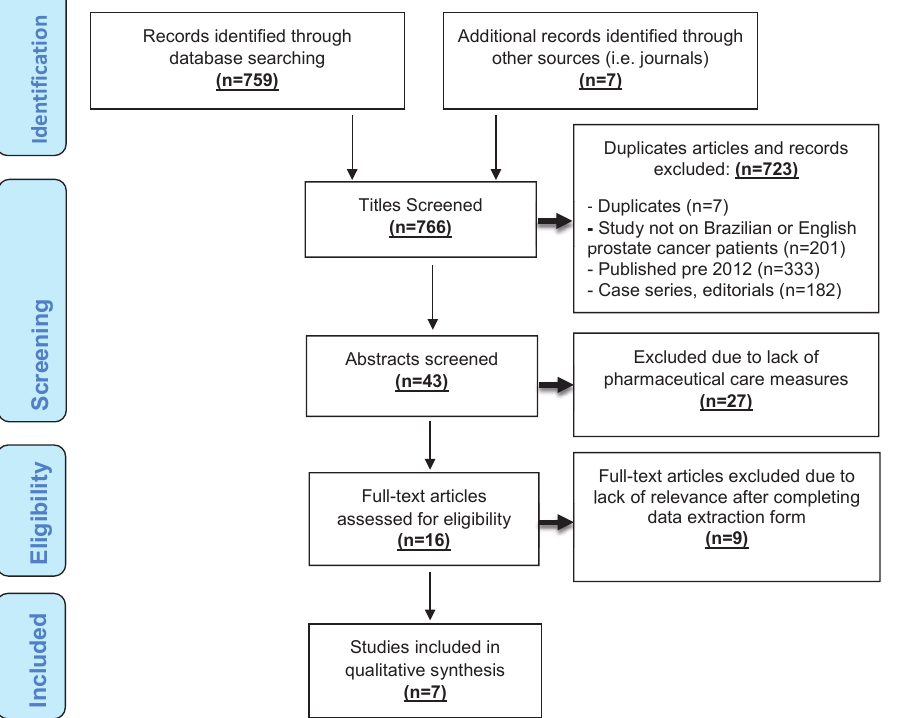
Figure 1 - PRISMA fl ow diagram showing the results of the literature